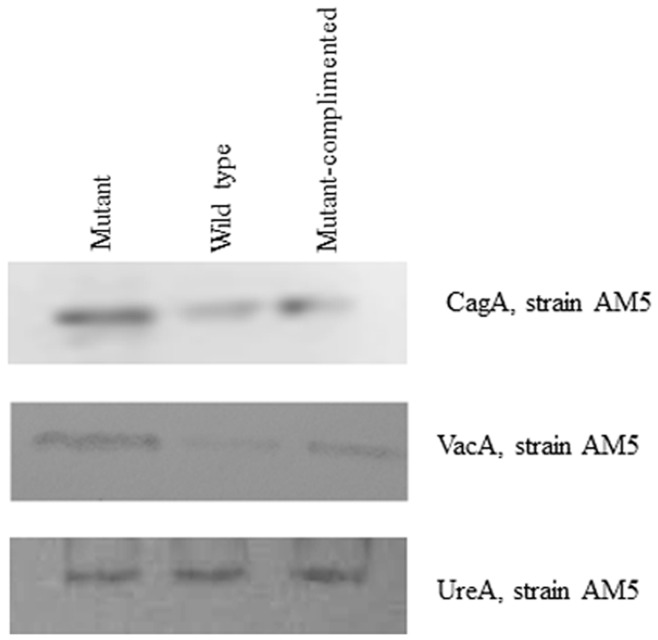
Western blotting for CagA and VacA protein levels in H. pylori strainsAM5 and AM5ΔhpyAVIBM.